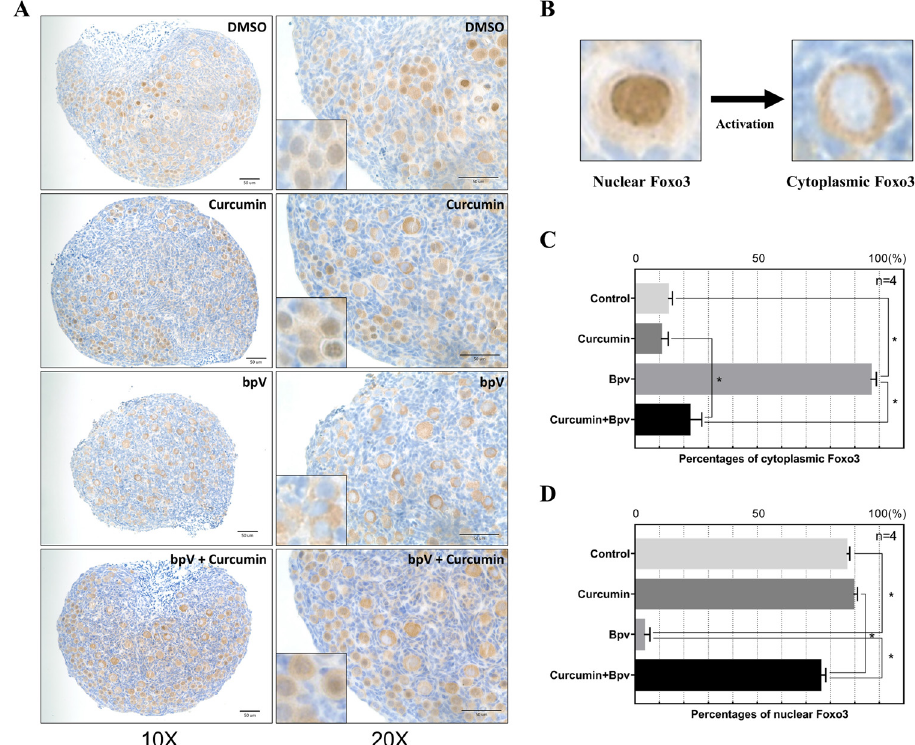
Figure 5. Curcumin inhibits follicle activation by reducing the translocation of FOXO3. ( A ) The ovaries of different treatments were collected for IHC staining with antibodies against FOXO3. The enlarged picture is shown at the bottom left. ( B ) Schematic diagram of nuclear and cytoplasmic FOXO3. ( C,D ) The percentage of cytoplasmic ( C ) and nuclear ( D ) FOXO3 from P3 ovaries treated with curcumin and/or bpV, * indicates p -value < 0.05.